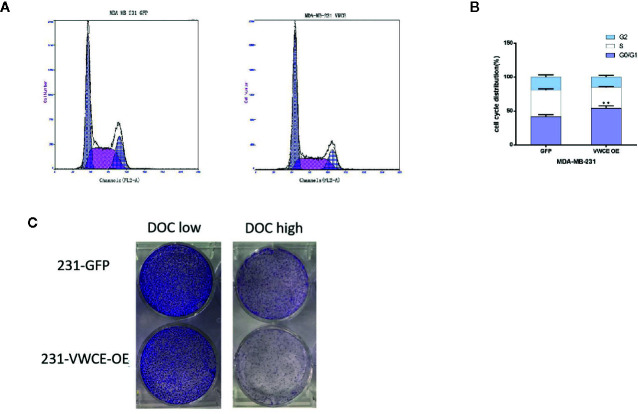
Von Willebrand factor C and EGF domain (VWCE) causes cell cycle arrest at the G1 phase and inhibits chemoresistance in breast cancer cells. Overexpression of VWCE inhibits cell cycle progression in MD-MBA-231 cells. (A, B) Flow-cytometry analysis showed that the overexpression of VWCE significantly causes a G0/G1 phase cell cycle arrest in MD-MBA-231 cells.**P < 0.01. (C) Clone formation in the control or over-expressing VWCE cells following treatment with DOC (2.5 nM) and DOC (5 nM) for five days.